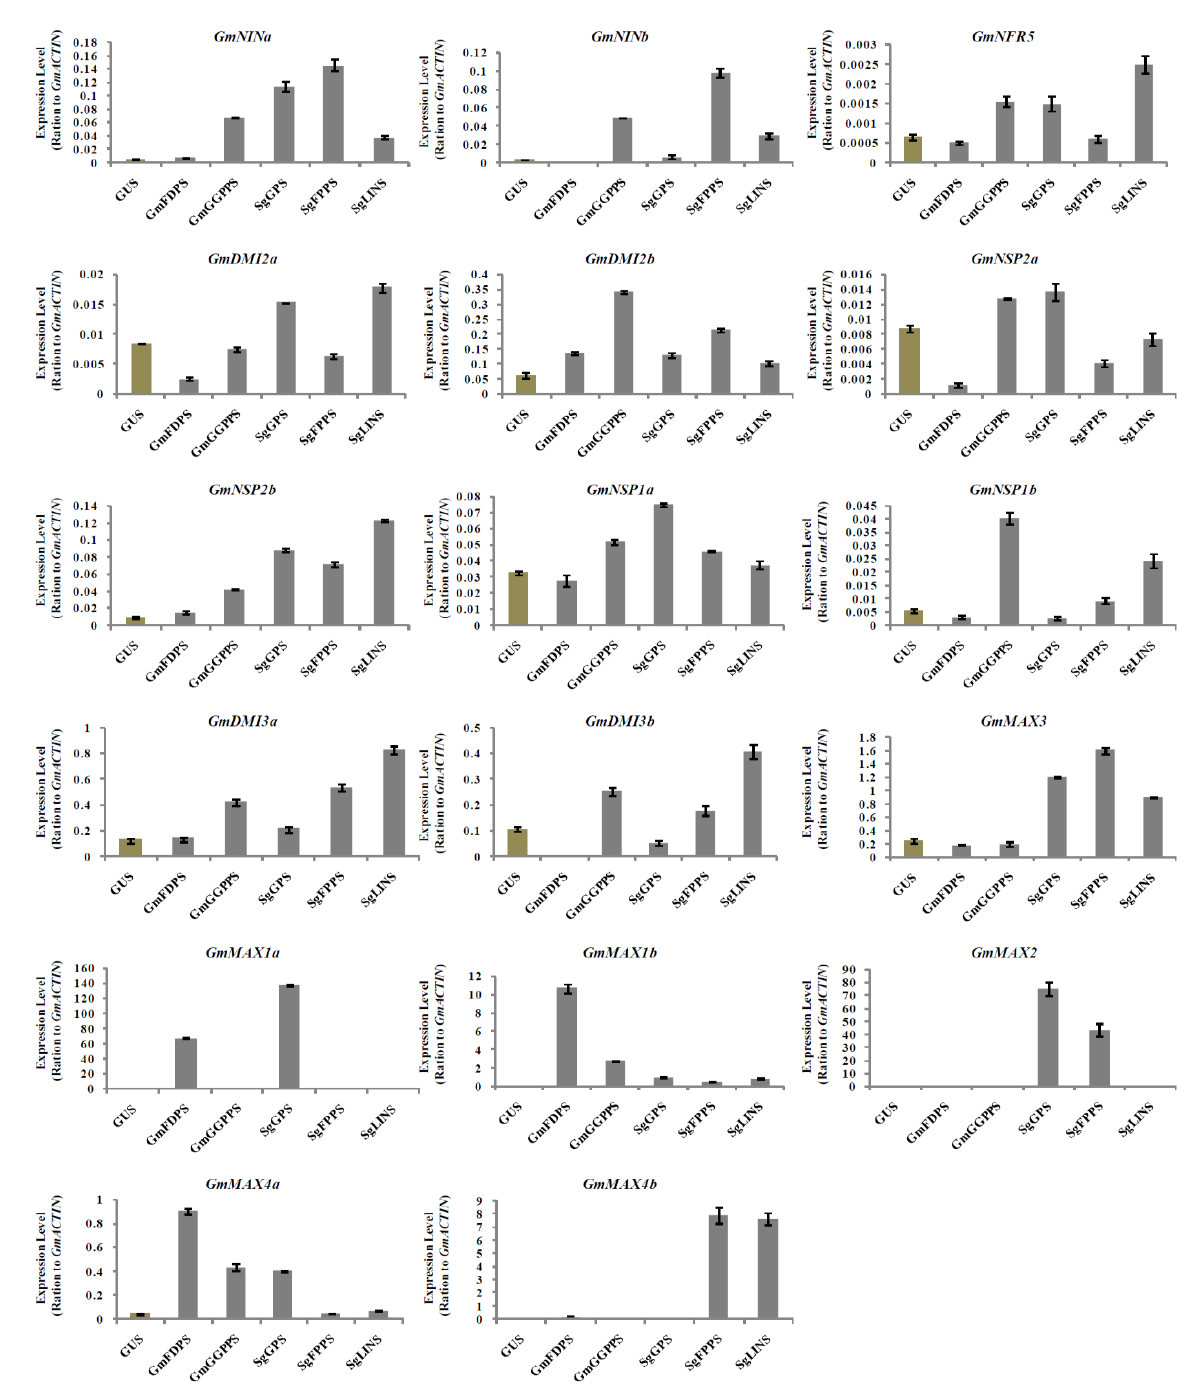
Figure 5. Expression profiles of SL biosynthesis and nodulation genes in soybean transgenic hairy roots after 10 days of rhizobia inoculation. Relative gene expression was analyzed using quantitative real-time PCR compared to GUS as a control. The housekeeping GmB-ACTIN gene was used as an internal reference gene for expression normalization. The error bars indicate the SD of three qRT-PCR biological replicates.